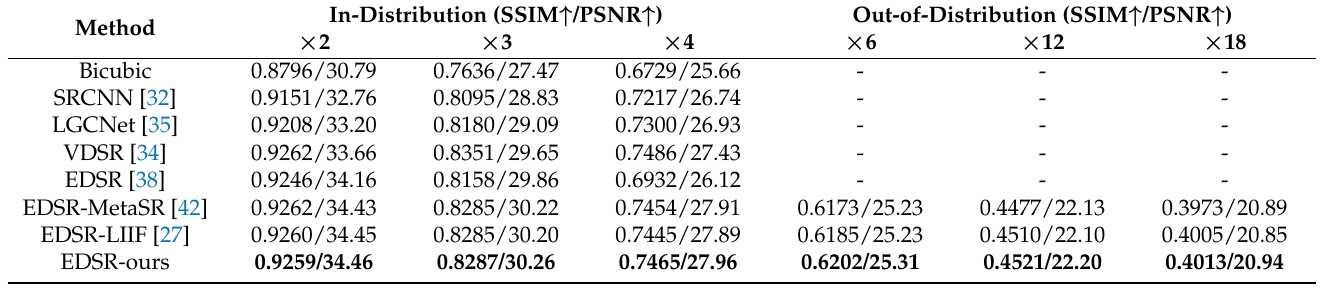
Table 2. Mean SSIM and PSNR (dB) of the UC Merced dataset(the bold in table is the highest value).